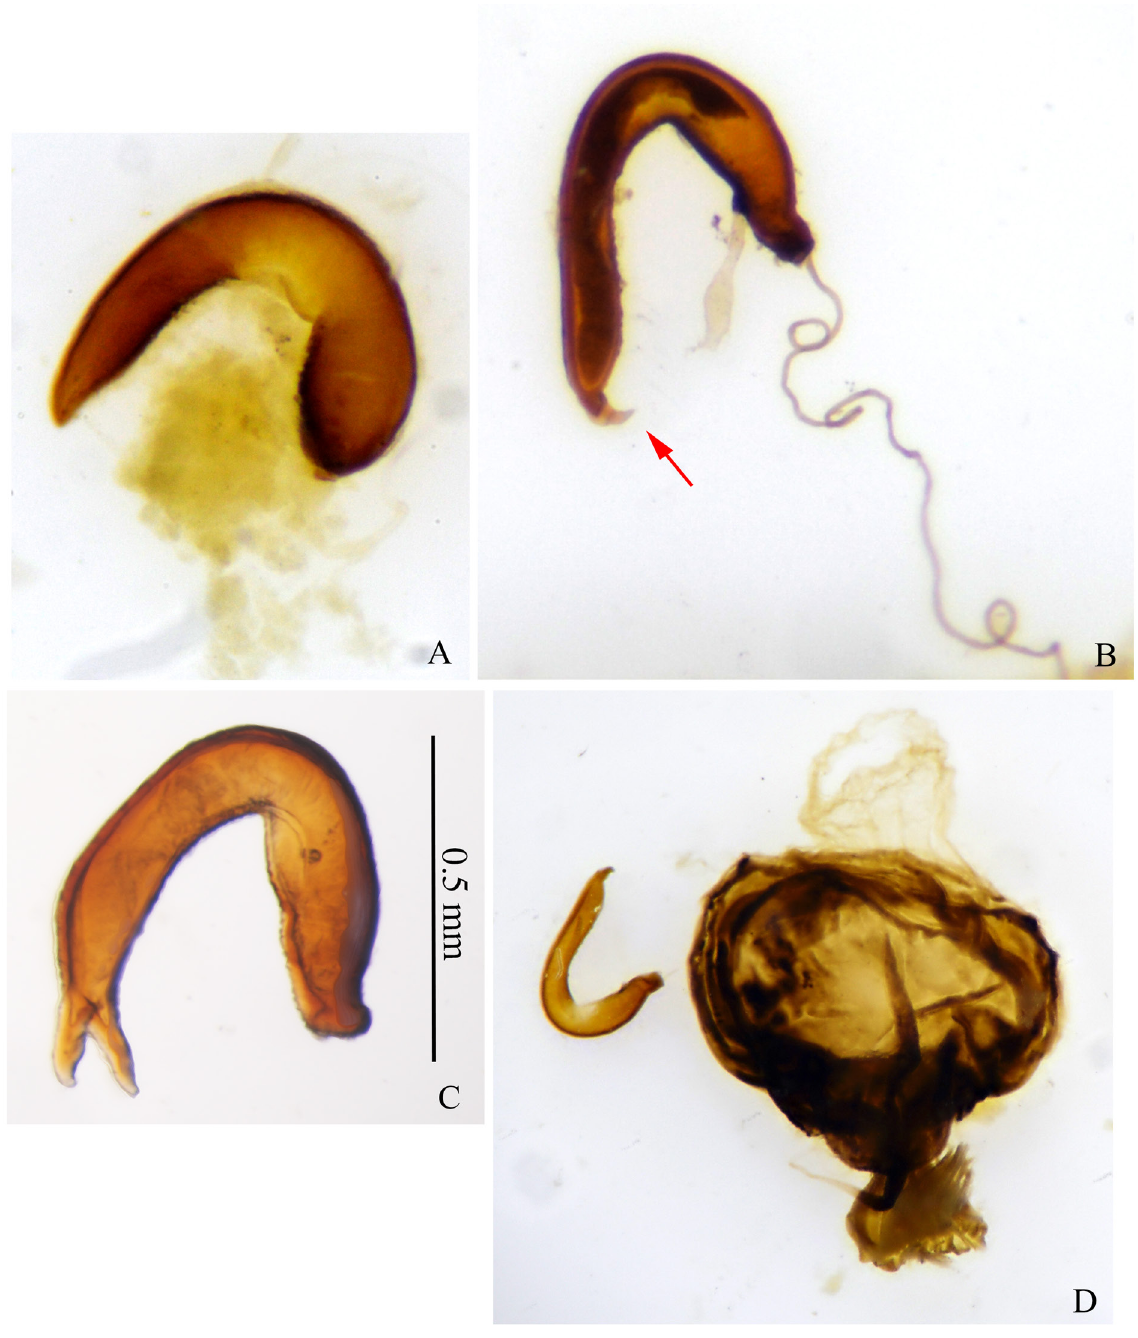
Fig. 27. Female genitalia. A‒C . Spermatheca. A . Streblopus opatroides van Lansberge, 1874. B‒C . S. punctatus (Balthasar, 1938) (slightly different views). Observe that the spermatheca of the latter species is more slender and has a unique pair of apical hooks (red arrow). D . General view of the entire female genitalia of S. punctatus